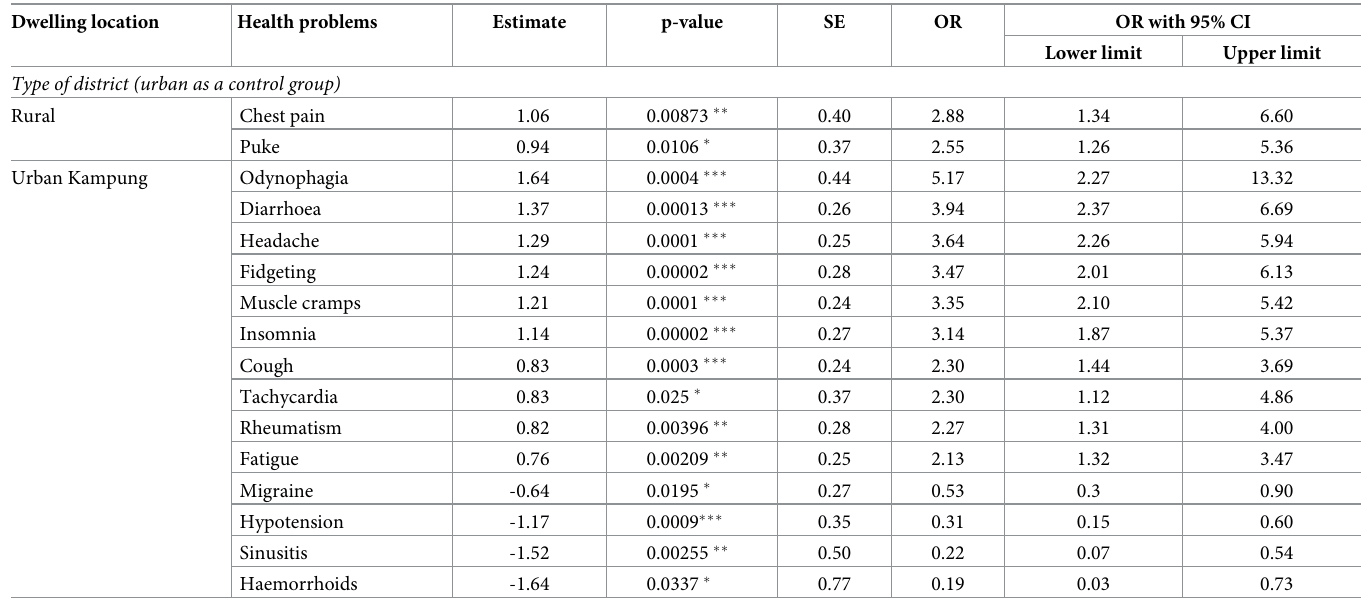
Table 4. Results of logistic regression models and odd ratios along with the 95% confidence intervals for the covariates related to dwelling locations. Dwelling